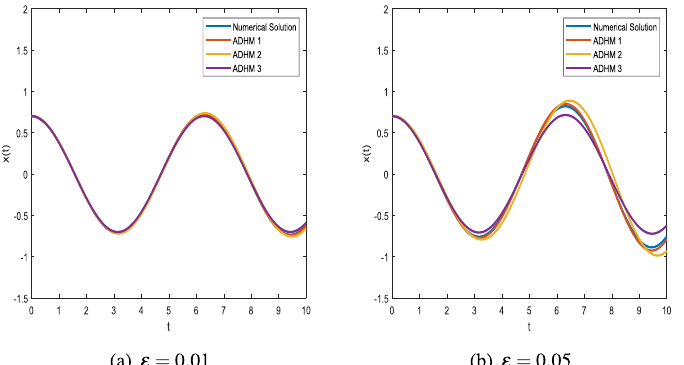
Figure 3. Comparison of ADHM results and numerical solution for parametric values x 0 = 0.7 and ω = 1 .